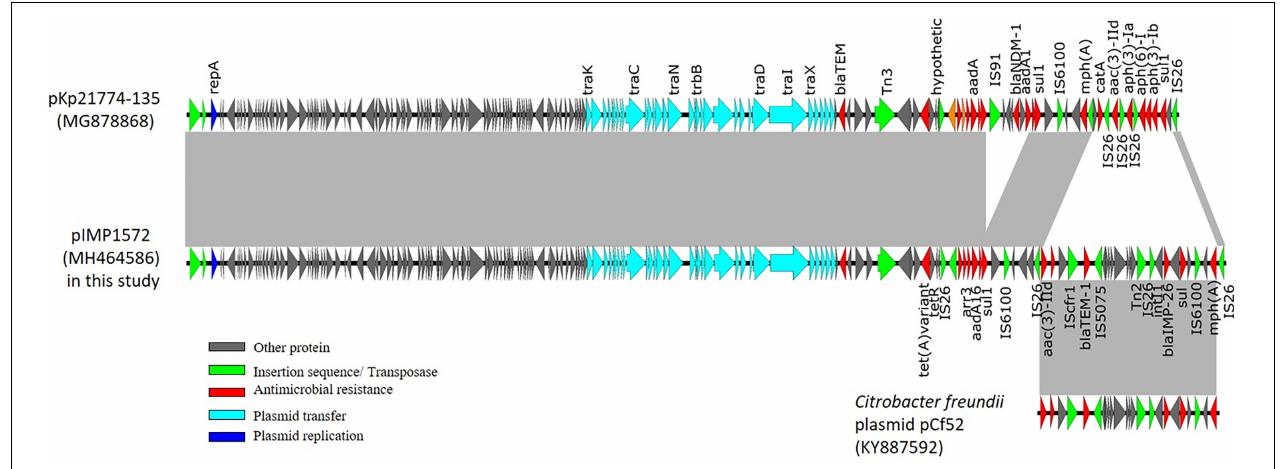
FIGURE 2 | The structure comparison of the plasmid pIMP1572 identified in this study with others published previously. The gray-shaded areas represent genomic regions that share 99% nucleotide sequence identities.